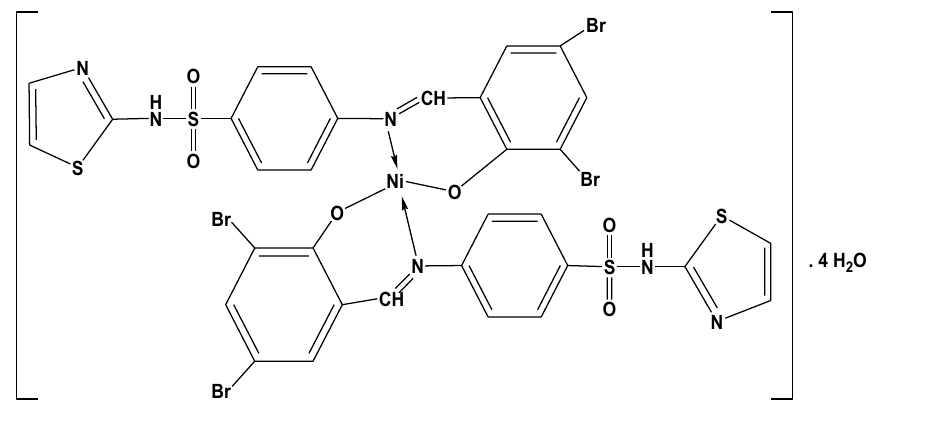
Figure 2. Structure of [Ni(SB 4 –H) 2 ]·4H 2 O